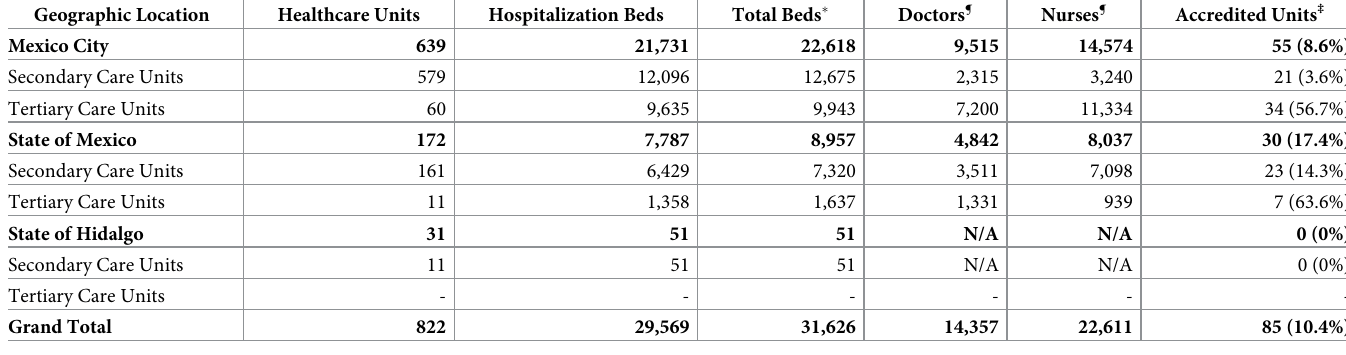
Table 2. Number of healthcare units and key indicators in the MCMA.